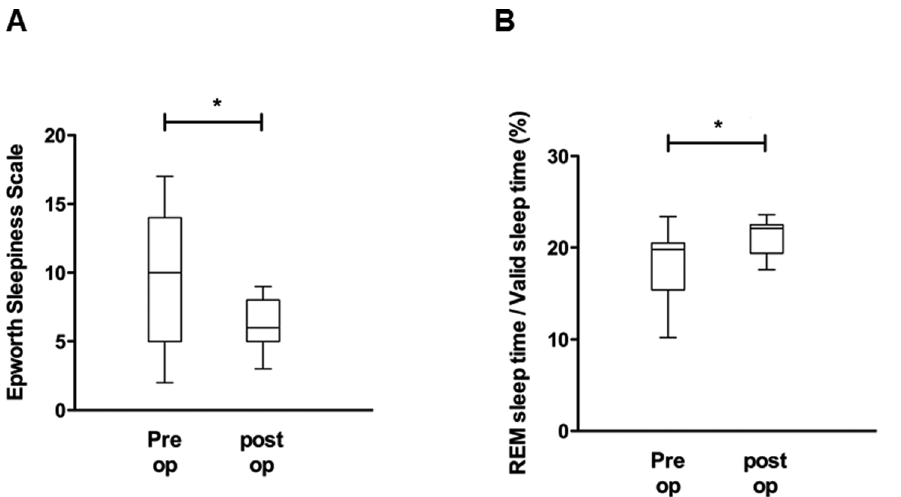
Figure 7. Changes in watch-PAT-derived factors, such as valid sleep time (A) and percentage of REM sleep (B), before and after nasal surgery in the non-responder group (N=11). * : p , 0.05 when comparing the pre-and post-operative